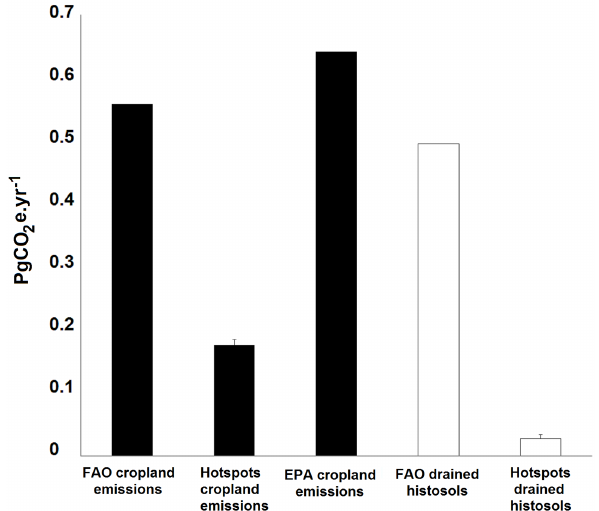
Figure 4. Disaggregation of cropland soil emissions from drained peatlands for datasets with available data: FAOSTAT and Hotspots. Organic soils are excluded in EPA cropland